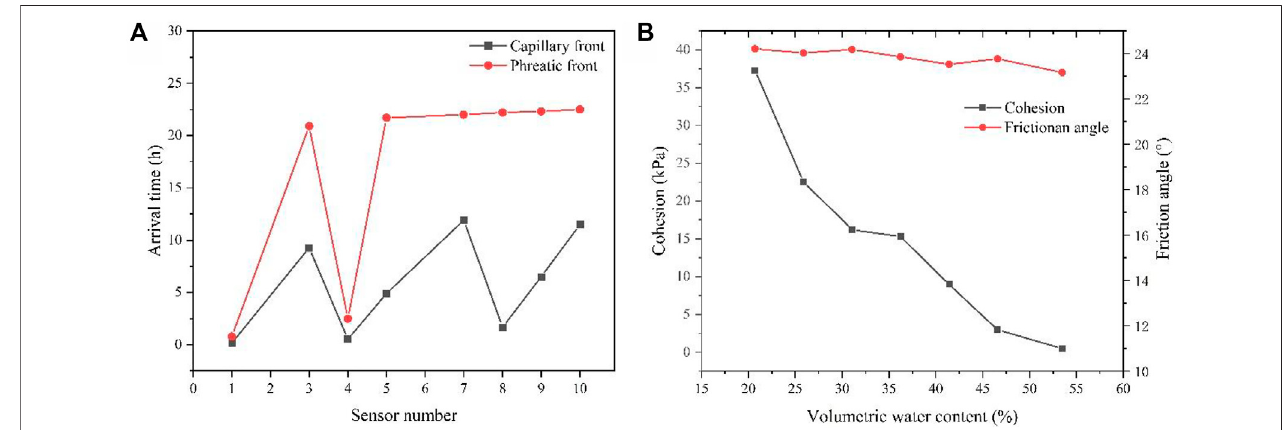
FIGURE14| Variationofcapillaryfront,phreaticfront,andshearstrengthparametersofdammaterialduringseepage. (A) Arrivaltimeofcapillaryfrontandphreatic front at the positions of water content sensors. (B) Shear strength parameters of dam material with different water content.